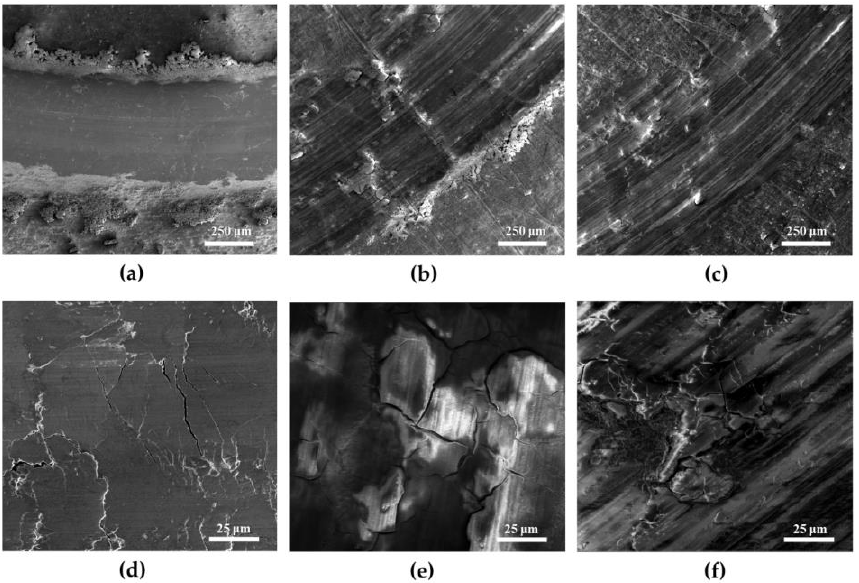
Figure 5. Wear tracks of the GHA / 100Cr6 system. Low magnification of: ( a ) GHA10, ( b ) GHA50 and ( c ) GHA100. High magnification of the inner details: ( d ) GHA10, ( e ) GHA50 and ( f ) GHA100.